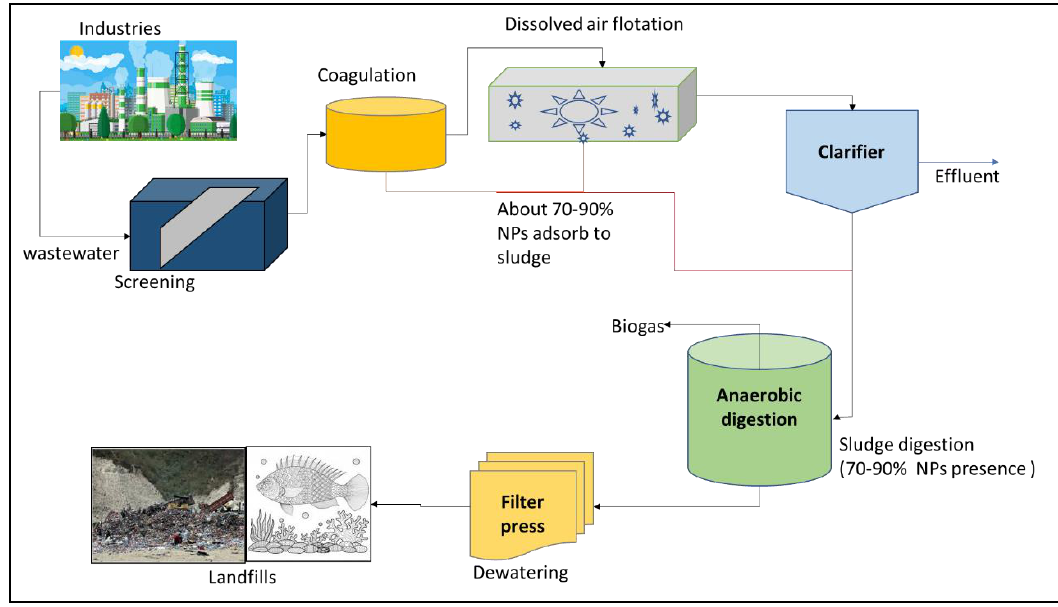
Figure 1. Schematic flow of a conventional wastewater treatment plant.